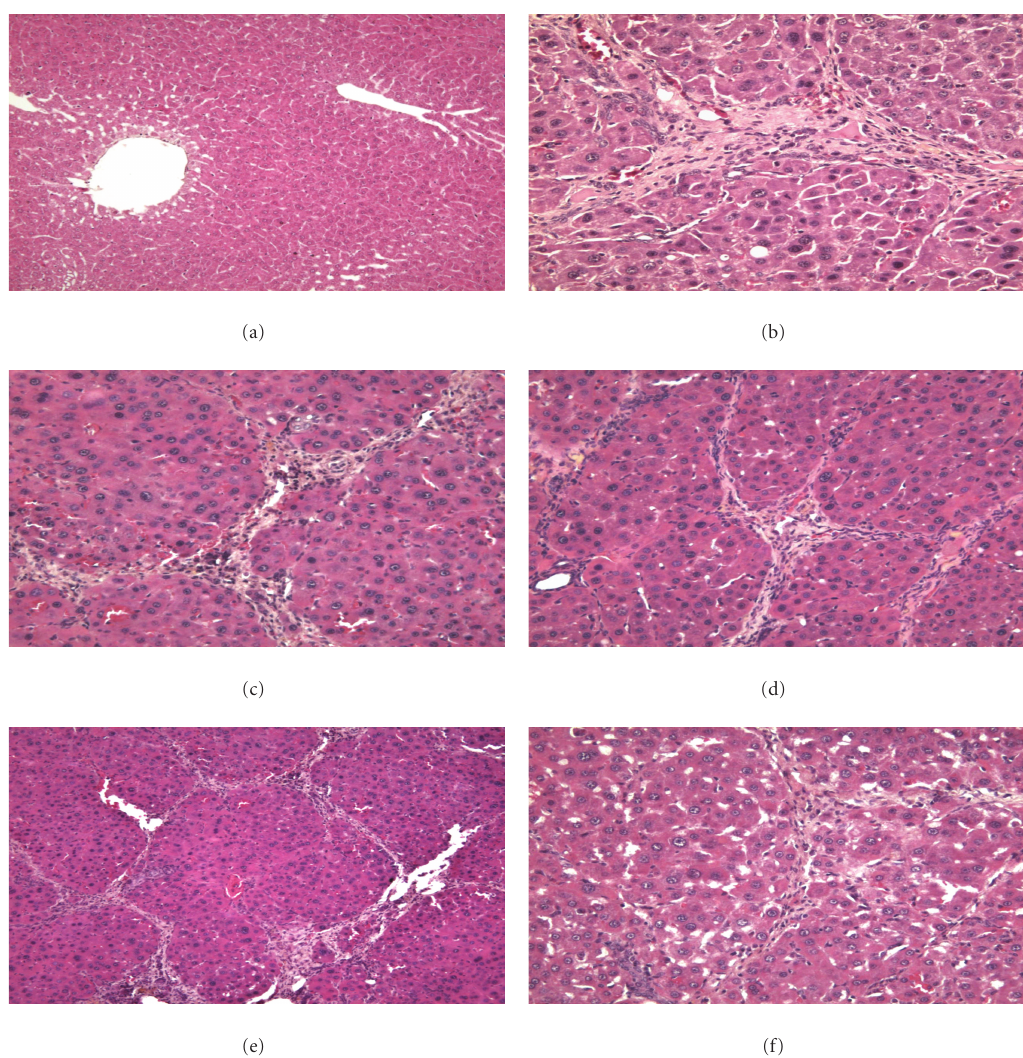
Figure 1: E ff ect of LEM on hepatic injury in CCl 4 -treated rats. All rats were received oral administration at indicated dose three times per day. (a) Normal rats treated with vehicle. (b) Normal rats treated with CCl 4 for 8 weeks. (c) CCl 4 -treated rats received oral administration of silymarin (200mg/kg) for 8 weeks. (d) CCl 4 -treated rats received oral administration of LEM (100mg/kg) for 8 weeks. (e) CCl 4 -treated rats received oral administration of LEM (200 mg/kg) for 8 weeks. (f) CCl 4 -treated rats received oral administration of LEM (500mg/kg) for 8 weeks. Histology of liver was characterized by staining with hematoxylin-eosin (Magnification: × 400).